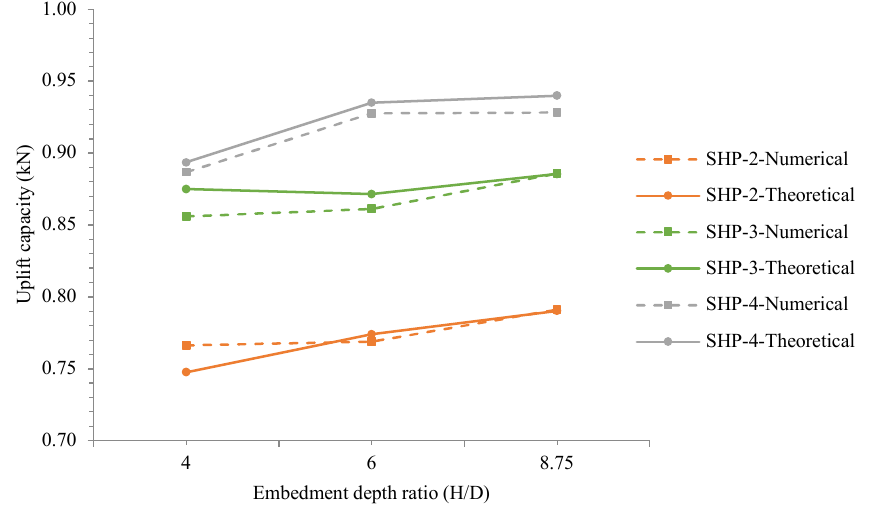
Figure 9. Comparison between theoretical and numerical results—Uplift loading.